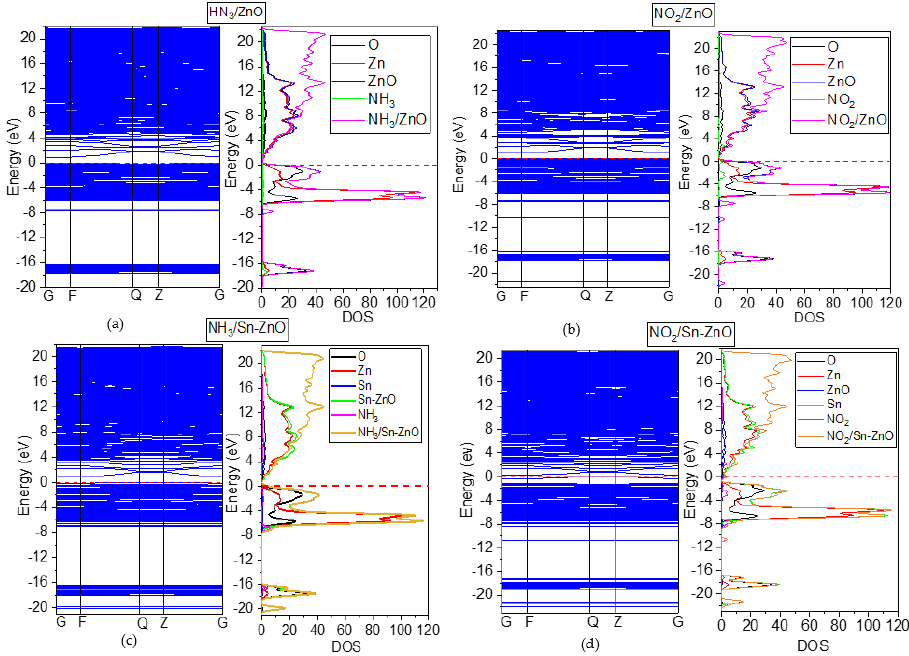
Figure 5. Band structures and DOS plots for chemisorbed ( a ) NH 3 /ZnO (101), ( b ) NH 3 /Sn − doped ZnO (101), ( c ) NO 2 /ZnO (101), and ( d ) NO 2 /Sn − doped ZnO (101)